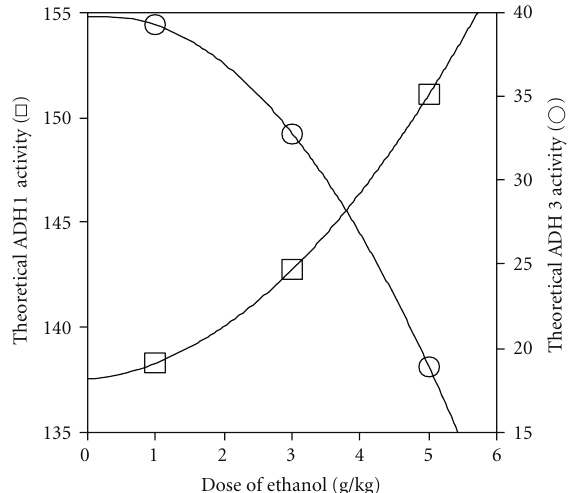
Figure 9: Correlation of β and normalized AUC (AUC/dose) of blood ethanol with theoretical ratio of activities of the two ADHs (ADH 3/ADH 1). The values of β ( (cid:2) ) and normalized AUC ( (cid:2) ) were from Figure 2. Theoretical activities of ADH 1 and ADH 3 were from Figure